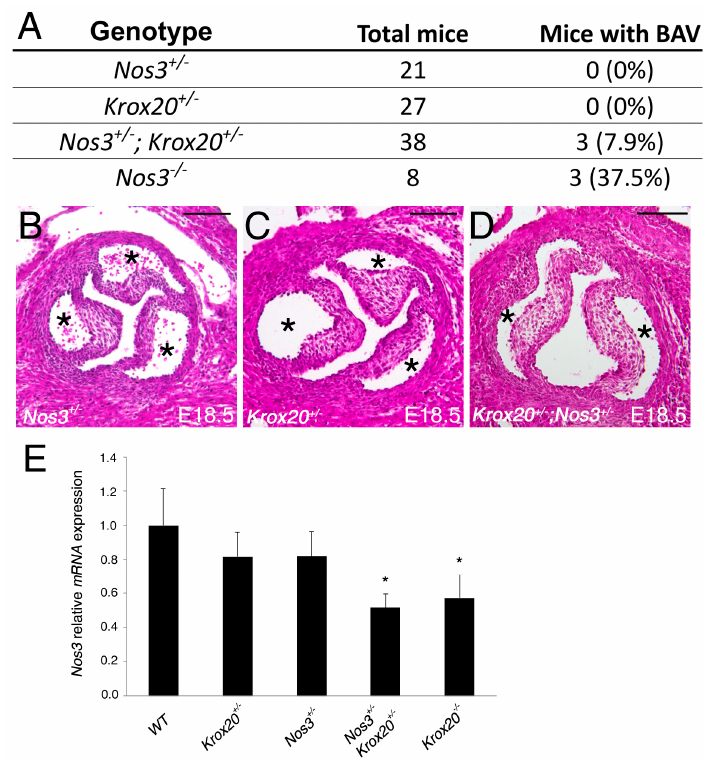
Figure 2. Abnormal aortic valve morphology in Krox20 +/ − ;Nos3 +/ − mice. ( A ) Table depicting penetrance of bicuspid aortic valve (BAV) in Nos3 +/ − , Krox20 +/ − , Nos3 +/ − ; Krox20 +/ − and Nos3 − / − mice. ( B – D ) H&E images showing representative Nos3 +/ − and Krox20 +/ − with tri-leaflets aortic valve, and an example of Nos3 +/ − ; Krox20 +/ − aortic valve with 2 leaflets. Aortic valve leaflets of Nos3 +/ − ; Krox20 +/ − mice appear equal in size. ( E ) Real-time qPCR demonstrates a reduction of Nos3 at a transcriptional level in Nos3 +/ − ; Krox20 +/ − and Krox20 − / − compared to wild-type embryos ( n = 5 for each genotype).